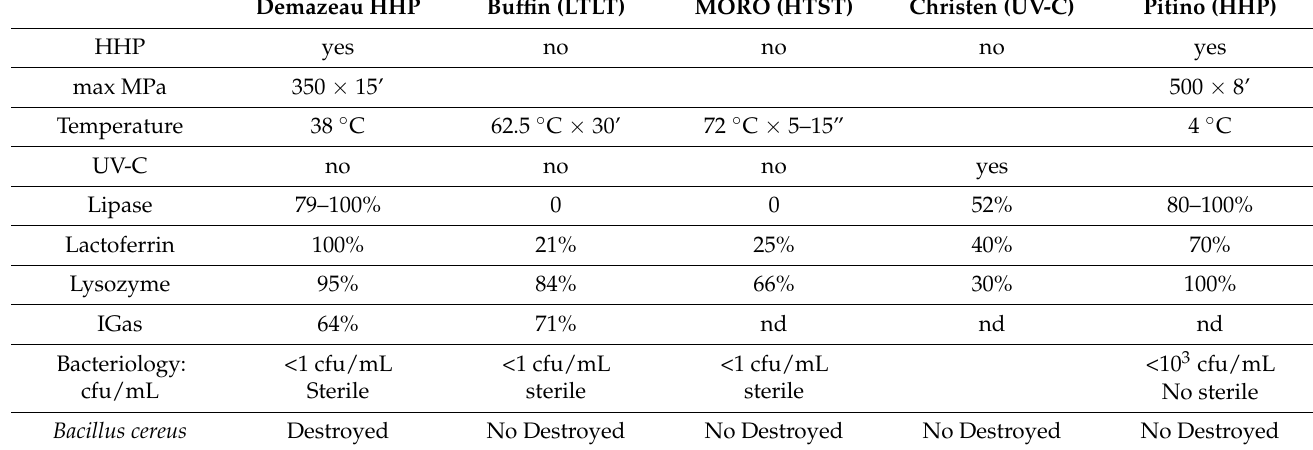
Table 1. Comparison of HHP, LTLT, HTST and UV-C expressed in percentage of raw Human Milk. HHP preserve Biocomponent of HM: Lipase, lactoferrin, lysozyme and IgAs, but Demazeau HHP is the lower pressure with a maximum of 350 MPa and four cycles, one between 50–150 MPa to allow the germination of Bacillus cereus Spores and the last cycle at 350 MPa destroyed the vegetative form; Pitino considered that <10 3 cfu is normal, but we consider that only <1 cfu/mL is sterile. Also, he did not do a challenge test with more than 10 6 of Bacillus cereus Spores , and we say that with only one cycle, we can destroy it, even with one cycle of HHP > 600 mPa.